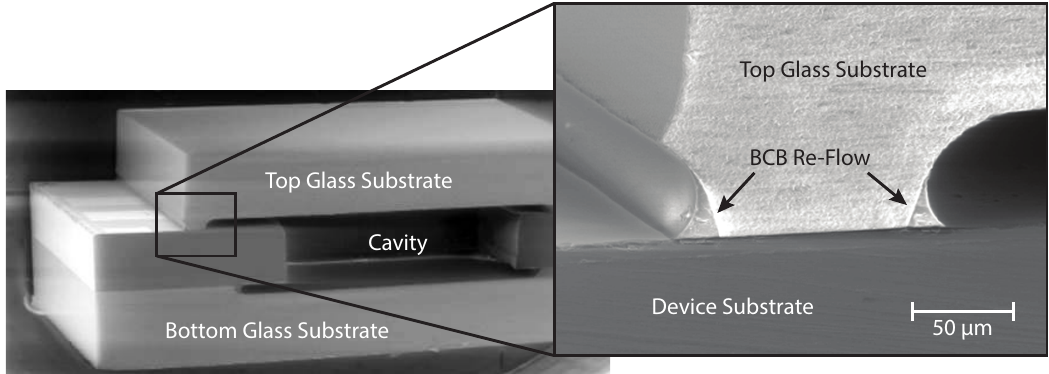
Figure 3. Scanning electron microscopy (SEM) cross-section of a front and back-side capped cavity, including partial dicing. No defects were found at the bond interface. The inset shows the re-flow behavior of the benzocyclobutene (BCB), which causes the accumulation of excess BCB at the edges